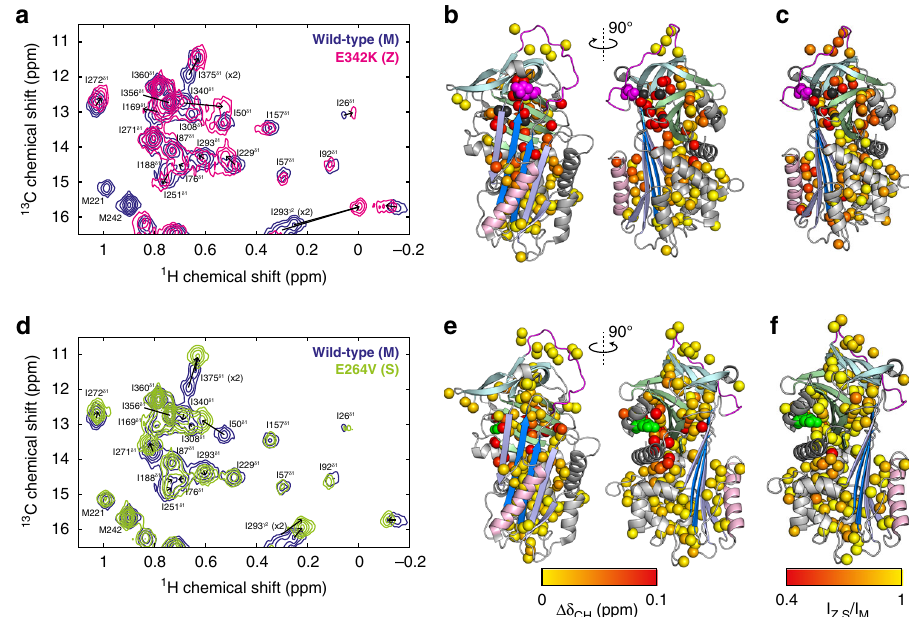
Fig. 5 Comparison of wild-type (M), Z and S AAT variants. a – c Comparisons of ex vivo NMR observations of M AAT with those of the Z variant, and d – f with the S variant. a , d Overlays of 1 H, 13 C SOFAST-gHMQC spectra (isoleucine region) for M, Z and S AAT, with resonance attributions indicated. Contour levels are normalised for concentration and acquisition time. b , e Combined methyl chemical shift changes between wild-type and variant AAT, q ffiffiffiffiffiffiffiffiffiffiffiffiffiffiffiffiffiffiffiffiffiffiffiffiffiffiffiffiffiffiffiffiffiffi (cid:3) (cid:4) 2 Δ δ ¼ Δ δ 2 þ Δ δ = 4 , projected onto the wild-type structure 72 . Resonances whose attribution could not be traced are indicated in dark grey, and CH C H mutations in the Z and S variants are indicated with magenta and green spheres, respectively. Colouring of secondary structure elements is consistent with Fig. 1b. c , f Intensity changes between M and Z/S variants of AAT, projected onto the wild-type recombinant AAT structure 72